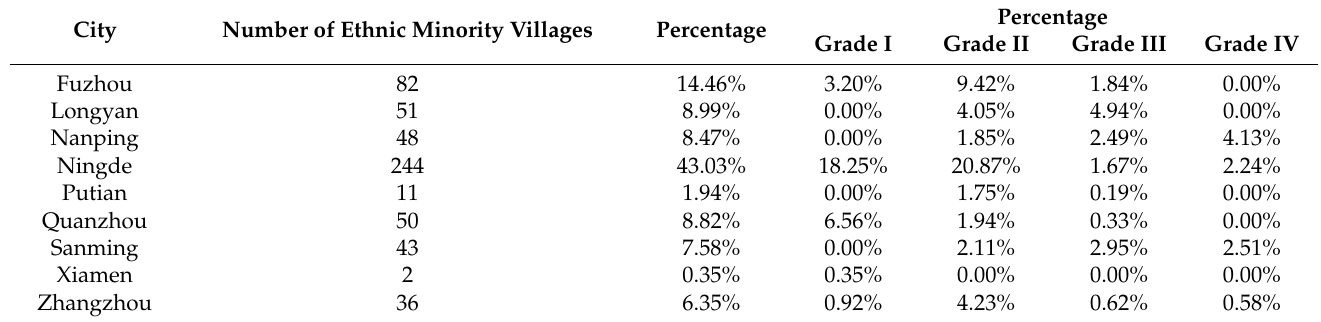
Table 6. Statistical results of suitability classification of ethnic minority villages in cities of Fujian